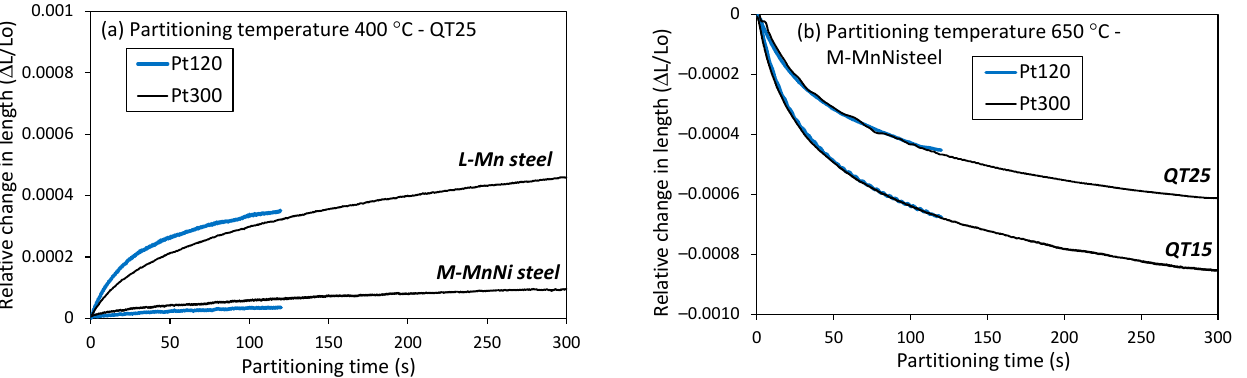
Figure 5. Relative change in length measured during the partitioning stage: ( a ) partitioning temper- ature of 400 °C in L-Mn and M-MnNi steels, with QT25 condition; ( b ) partitioning temperature of 650 °C in M-MnNi steel, with QT25 and QT15 conditions. The curves corresponding to Pt120 and Pt300 are shown in each condition.